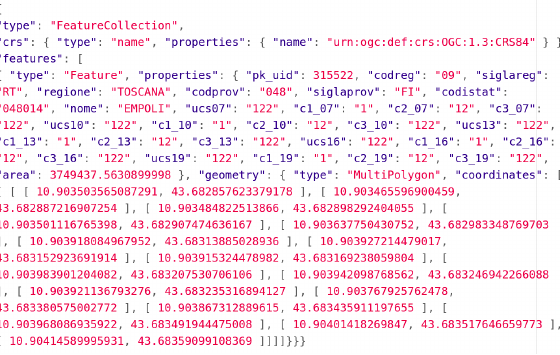
Figure 2. An object from Experiment 3’s GeoJSON dataset, where coordinates are represented to 15 decimal